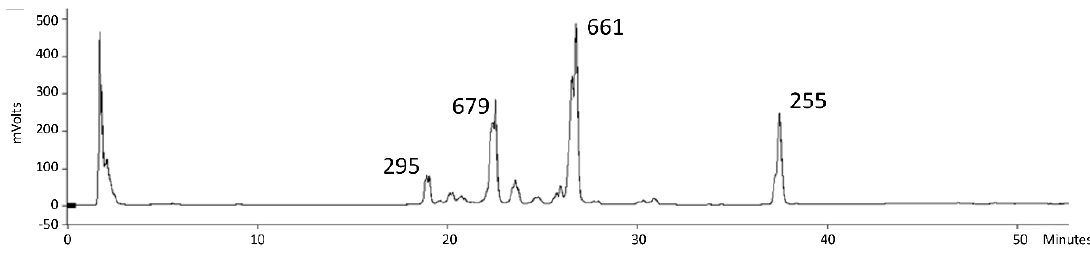
Figure 6. Sophorolipids produced in a 3-L fermenter using ethyl palmitate. At 18.9 min, non-acetylated acidic C16:0 sophorolipids eluted (295 m / z ). Di-acetylated congeners were present around 22.4 and 26.6 min, corresponding to acidic and lactonic sophorolipids, respectively (679 and 661 m / z ). Palmitic acid eluted at 37.4 (255 m / z ).